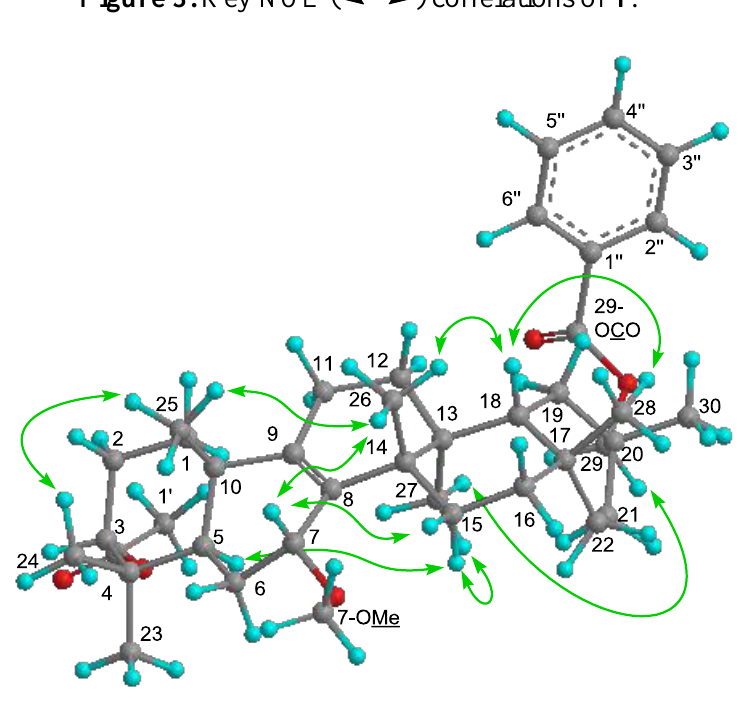
Figure 3. Key NOE ( ) correlations of 1